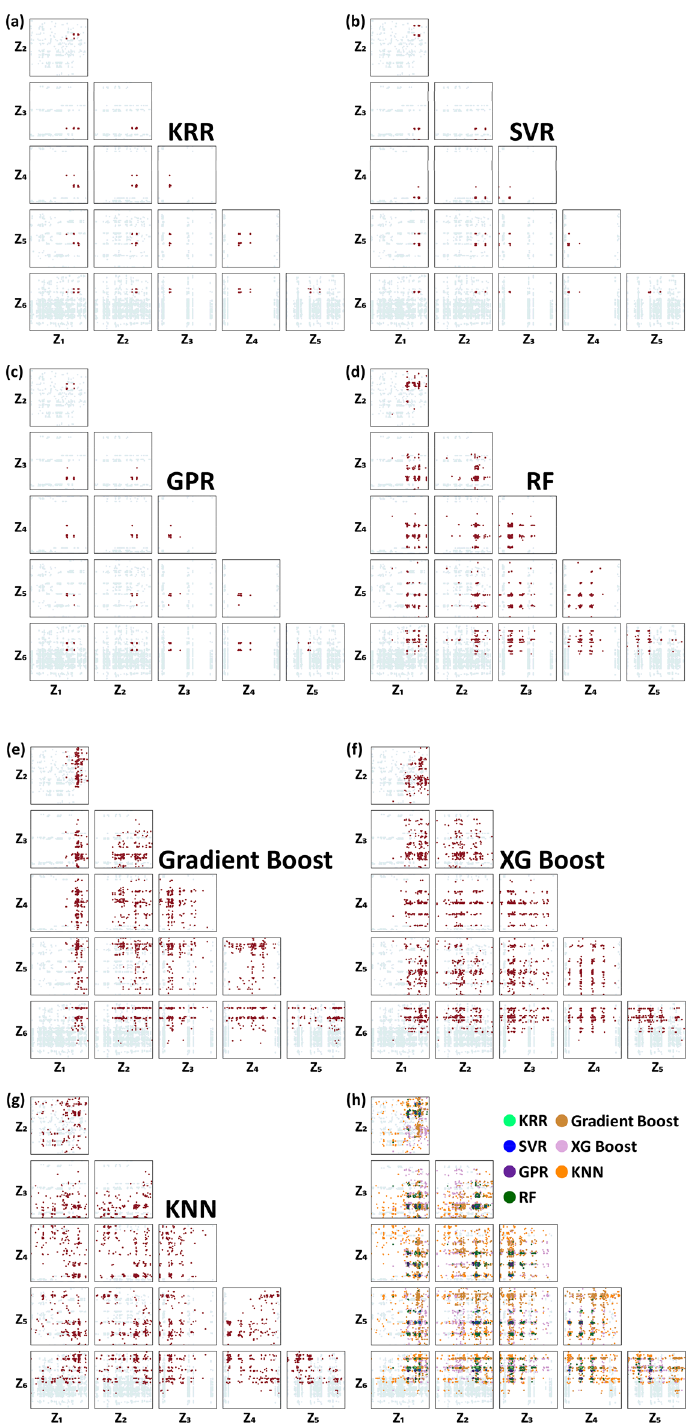
Figure 6. Alternative HRS representation; 15 2-D HRS plots involving six z j features (four z j features (z 1 –z 4 ), each of which was mapped from three x i features and two z j features (z 5 and z 6 ) from two x i features per each), considered as an HRS representation unit. Inverse-predicted solutions for ( a ) KRR, ( b ) SVR, ( c ) GPR, ( d ) RF, ( e ) Gradient Boost, ( f ) XG Boost, and ( g ) KNN regression models. The entire dataset was also plotted as a background and the solutions from each ML algorithm are highlighted in dark red color. ( h ) The solutions from all the seven ML algorithms are merged in a single HRS representation